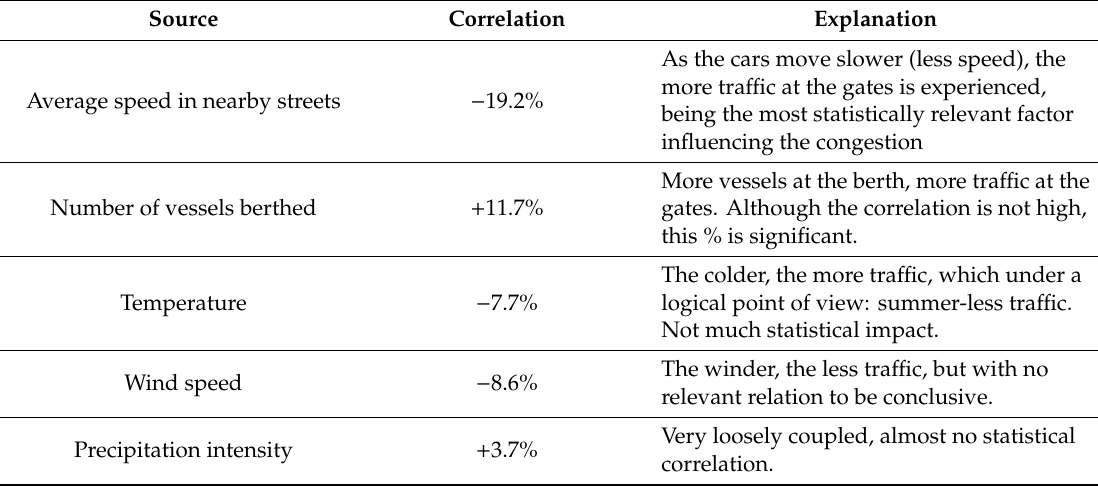
As the cars move slower (less speed), the more tra ffi c at the gates is experienced, being the most statistically relevant factor influencing the congestion More vessels at the berth, more tra ffi c at the gates. Although the correlation is not high, this % is significant. The colder, the more tra ffi c, which under a logical point of view: summer-less tra ffi c. Not much statistical impact. The winder, the less tra ffi c, but with no relevant relation to be conclusive. Very loosely coupled, almost no statistical